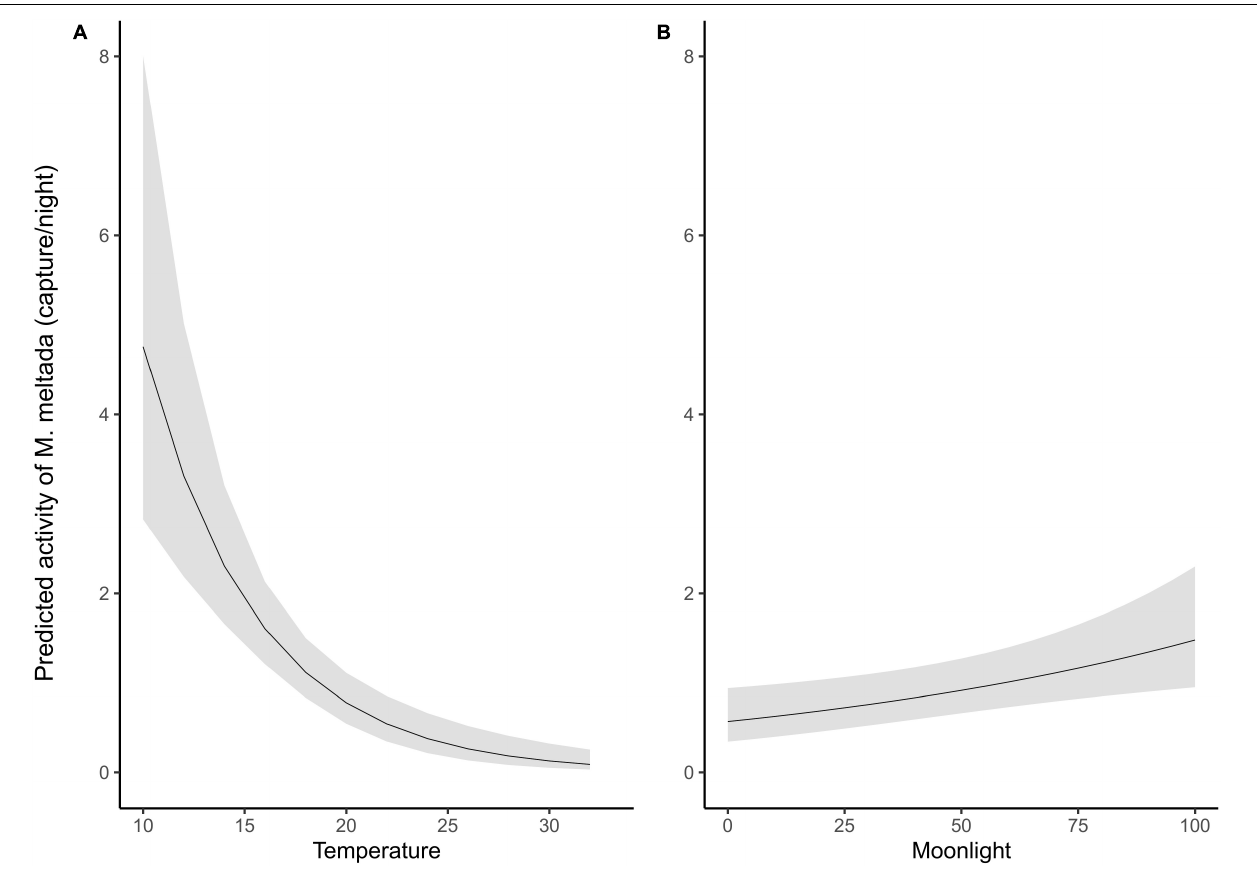
FIGURE 4 | Predicted response of the activity of M. meltada to different predictor variables based on top model; (A) effect of temperature (B) effect of